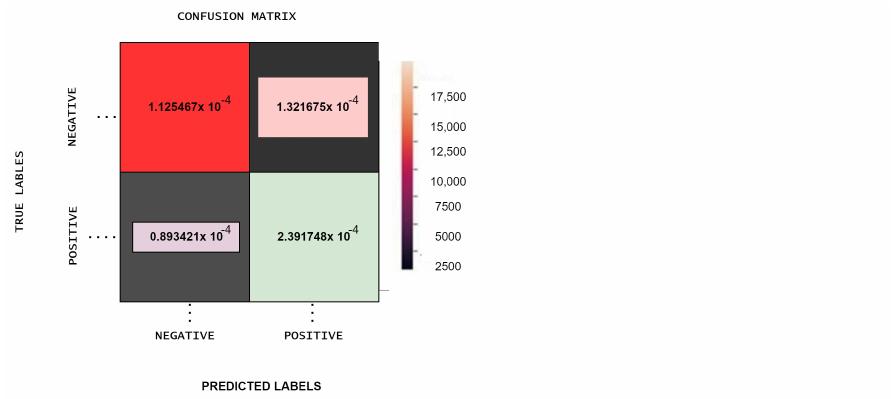
Figure 11. Obtained Confusion matrix for Trained Data.